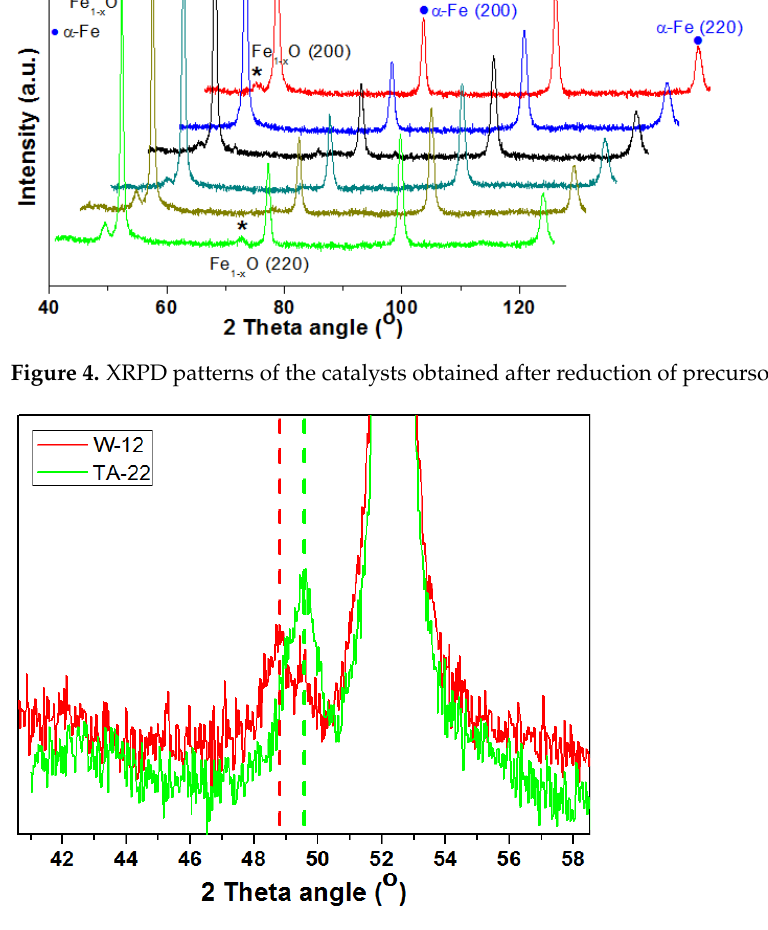
Figure 5. XRPD patterns of the catalysts after reduction at 500 °C, which represent a shift.